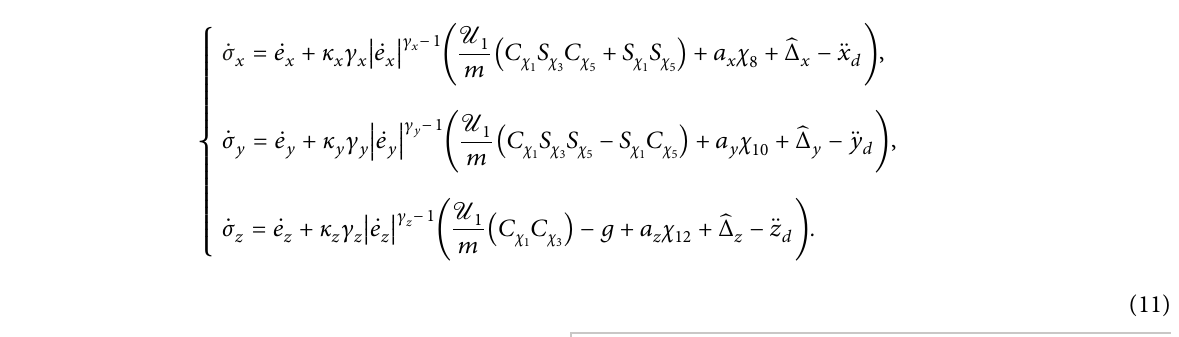
Figure 2: Proposed control flowchart for the quadrotor